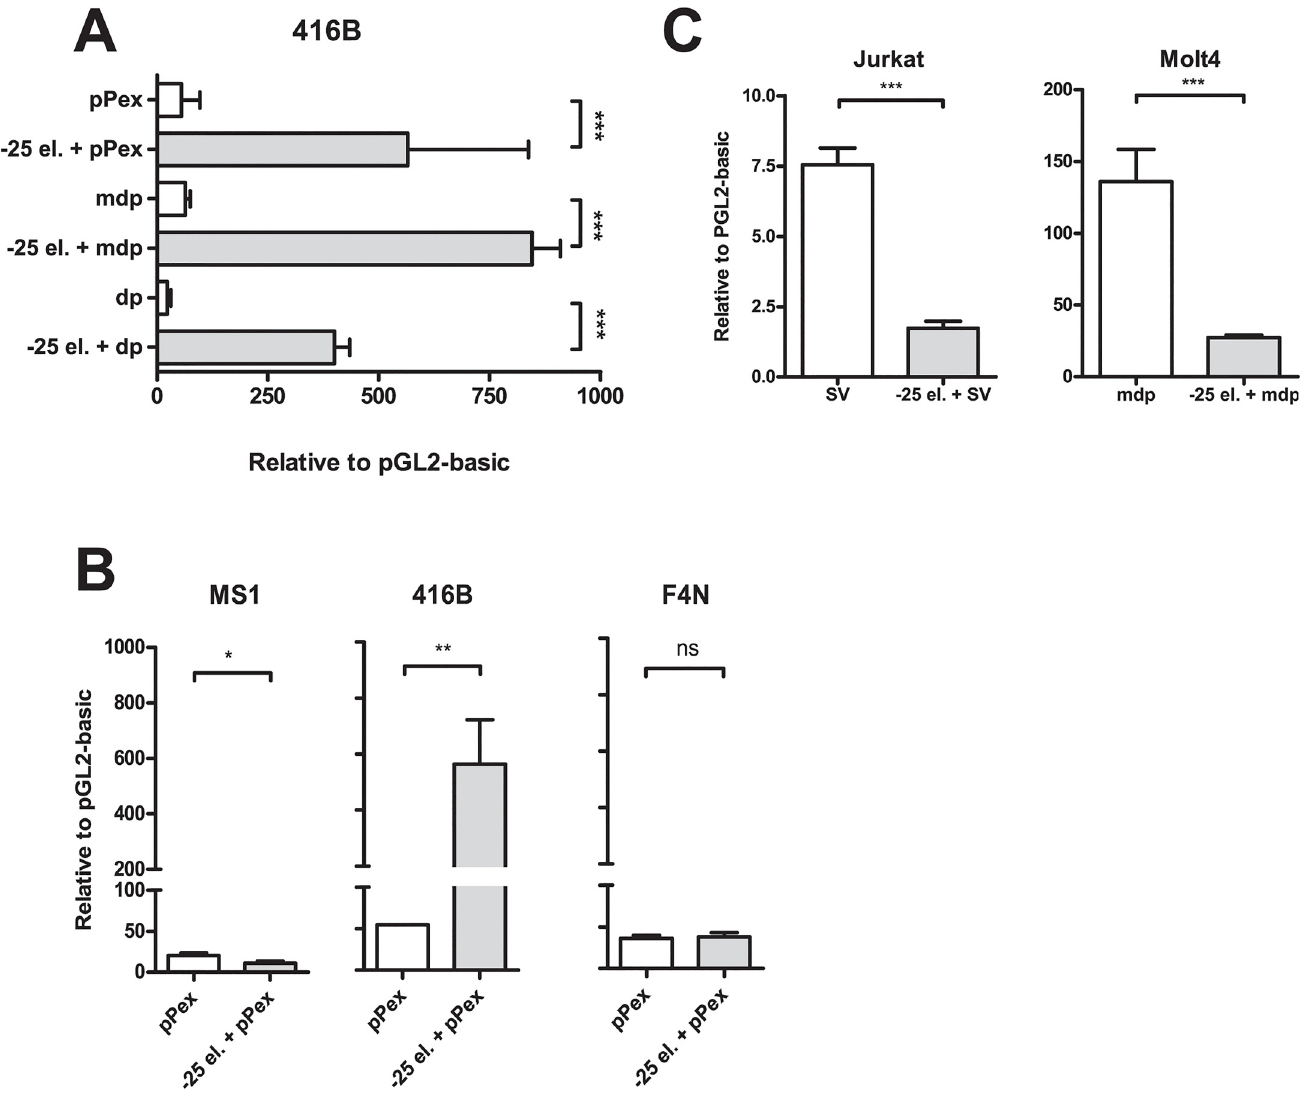
Fig 1. Cell-type specific activity of LMO2 element -25. A) Promoter-independent enhancer activity of element -25 in multipotent myeloid progenitors 416B. Luciferase activity of LMO2 proximal (pPex), intermediate (md) or distal (dp) promoter elements in the presence and absence of element -25 (-25 el.) was measured in 416B cells. B) Cell-type specific activity of -25kb DRE. Luciferase experiments were performed in endothelial MS1 and erythroid F4N cells using LMO2 proximal (pPex) promoter element in the presence and absence of element -25 (-25 el.). For comparison purposes, 416B data from panel A is also shown. C) T-cell repressor activity of element -25. Luciferase experiments were performed in LMO2 expressing Molt4 and LMO2 non-expressing Jurkat cells, using, respectively, LMO2 intermediate (md) or minimal SV promoter elements in the presence and absence of element -25 (-25 el.). In all cases, mean and standard error of the means (SEM) for at least two independent stable transfections (each one performed at least in triplicate) are shown. Values are expressed relative to empty vector, pGL2 basic. * P < 0.05; ** P < 0.01; *** P < 0.001; ns, not